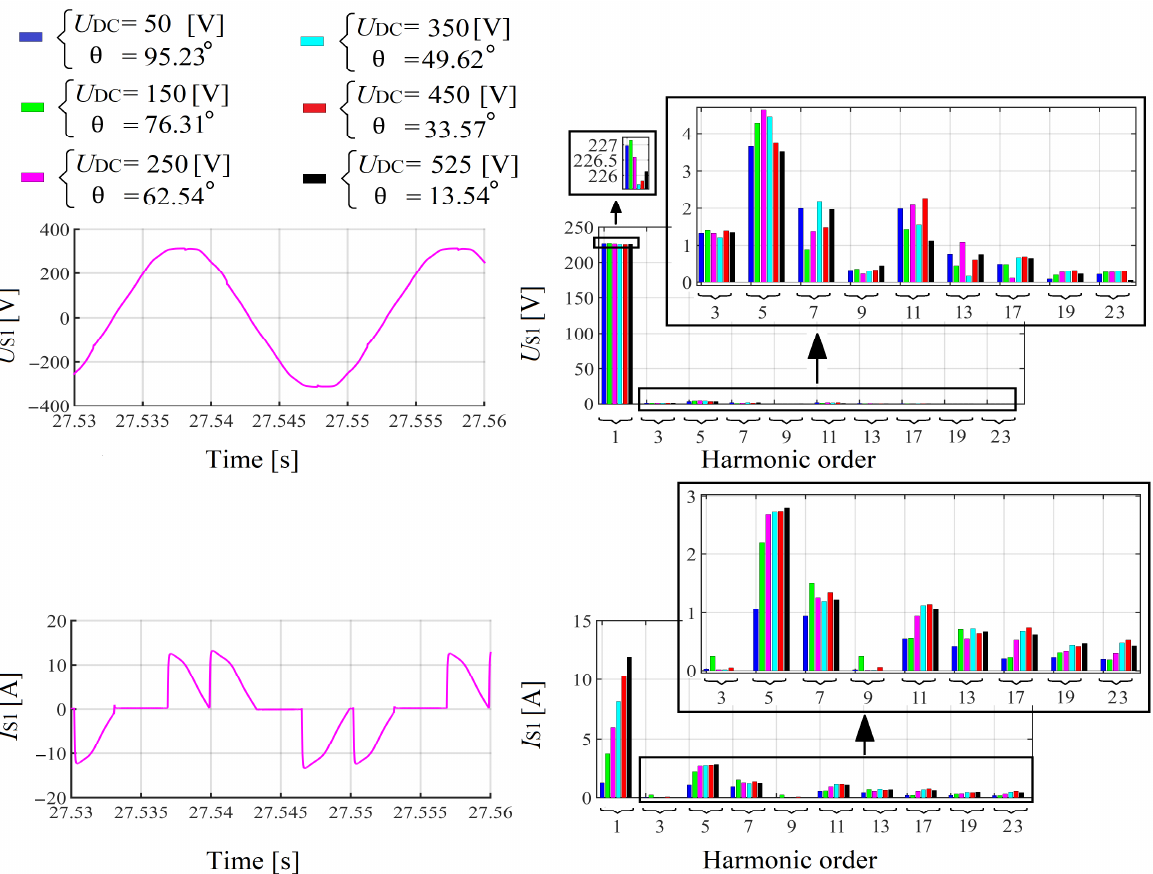
Figure 6. Grid voltage and current parameters measured from the laboratory setup. The example of waveforms is for the U DC equal to 250 V.